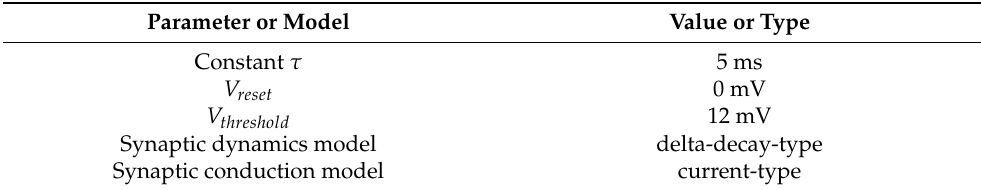
Table 1. Parameter values and model types used in the experiment.